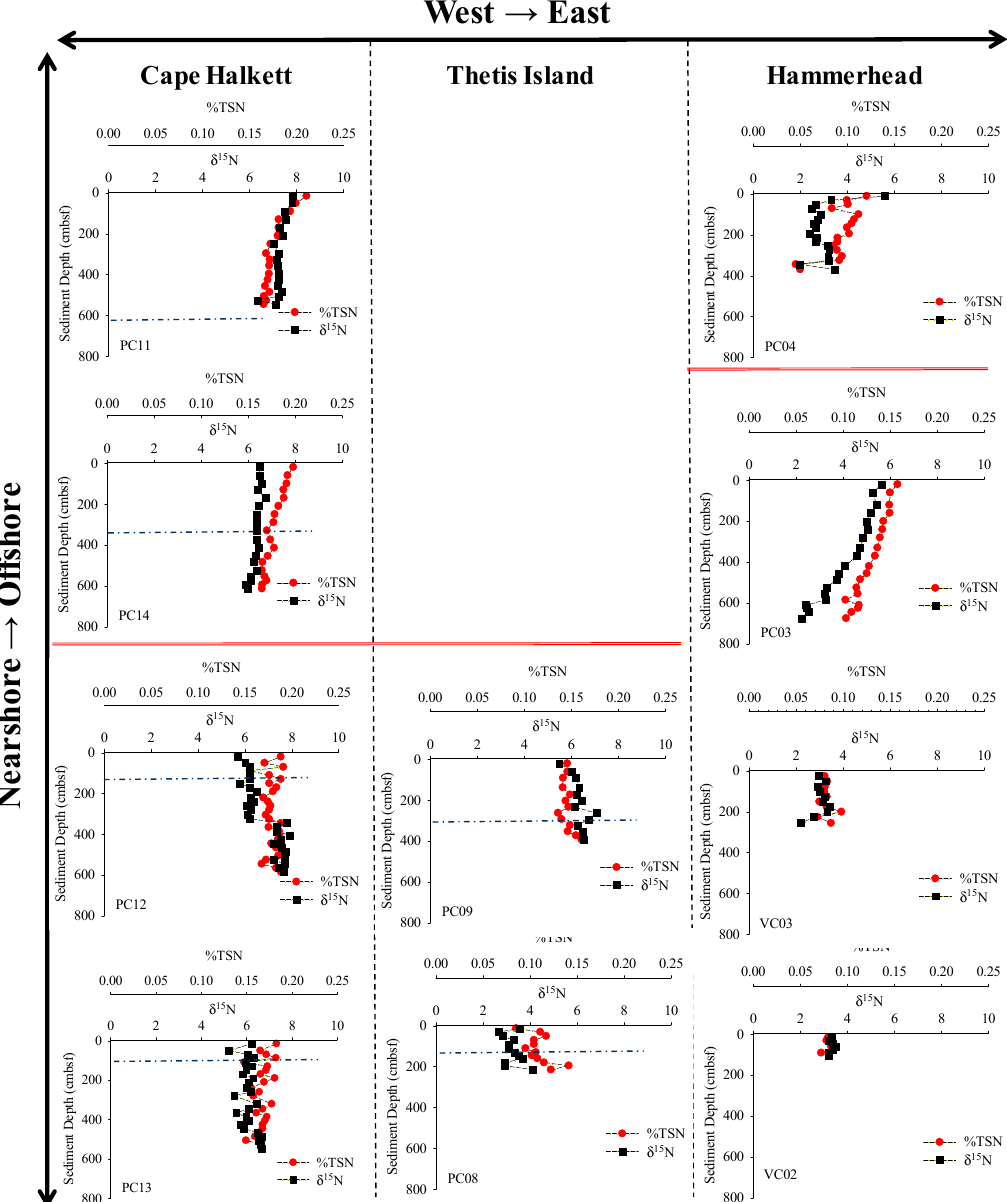
Figure 4. Sediment % total sediment nitrogen (TSN) and δ 15 N plotted vs. depth (cm) in the sediment below seafloor (cmbsf) for cores collected along the North Slope of Alaska on the Beaufort Sea. Core profiles are separated into three distinct sampling transects (Cape Halkett, Thetis Island and Hammerhead) and displayed by relative location west-to-east (left-to-right) and offshore-to-nearshore (top-to-bottom) on the North Slope. The blue dashed line presented in plots with a measured SMT represents the depth reported in Table 1. The red line in each transect indicates the relative location of the shelf-break for each coring transect (Figure 1). Porewater DOC—measured porewater DOC concentrations ranged from 0.44 to 6.95 mM, with an increase with depth in the sediments observed at all sites (Figure 5). The highest porewater DOC concentrations were found at the Thetis Island nearshore site (PC08) and along the Cape Halkett line; 4.23 ± 2.01 mM ( n = 12) and 3.17 ± 1.29 mM ( n = 88), respectively. Porewater DOC concentrations were